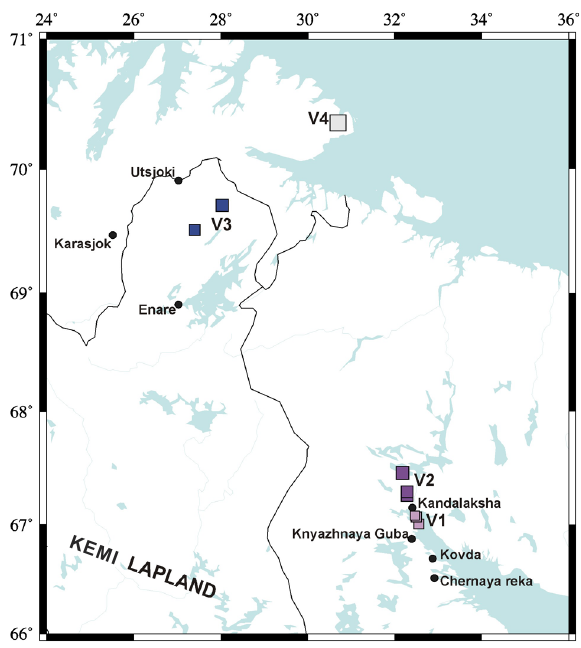
Figure 6. Squares denote possible epicenters associated with differ- ent magnitudes for the earthquakes of December 17 (V1 and V2) and 31 (V3 and V4), 1758.